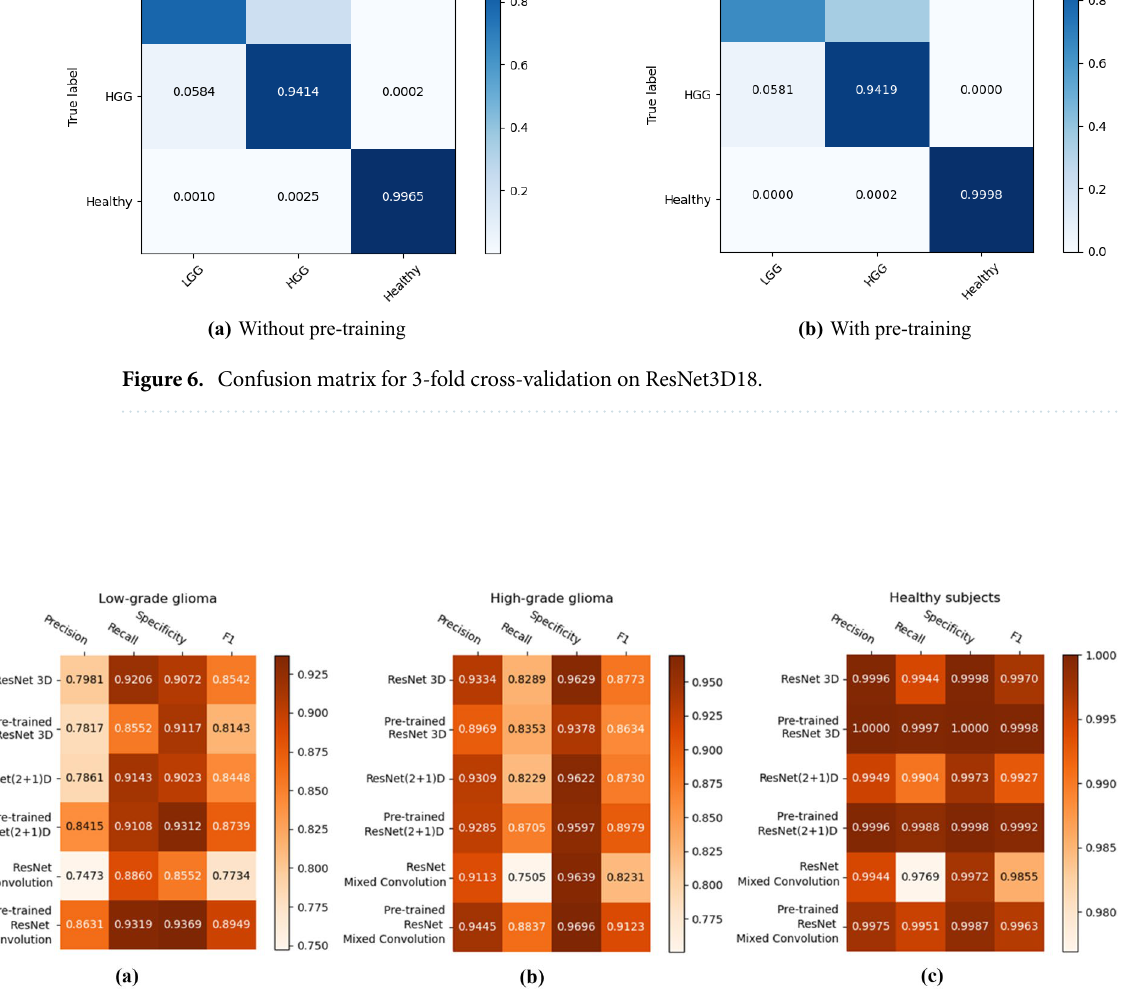
Figure 7. Heatmaps showing the class-wise performance of the classifiers, compared using precision, recall, specificity, and F1-score: ( a ) LGG, ( b ) HGG, and ( c )